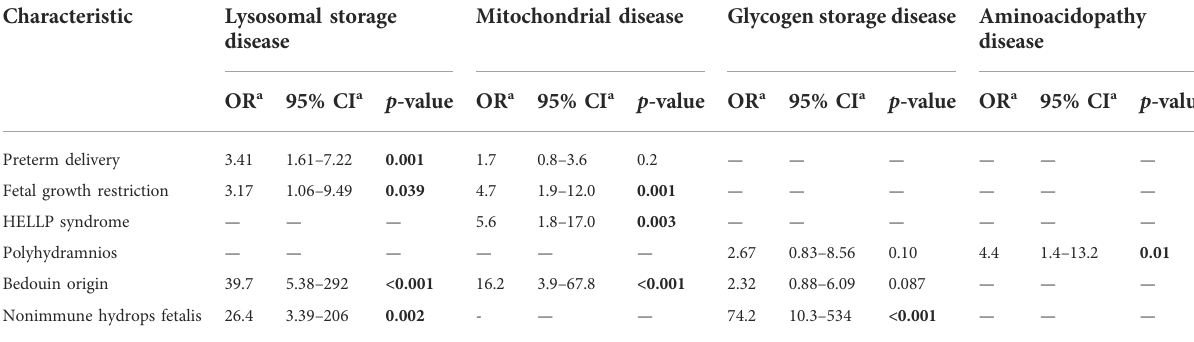
a OR, odds ratio; CI, con fi dence